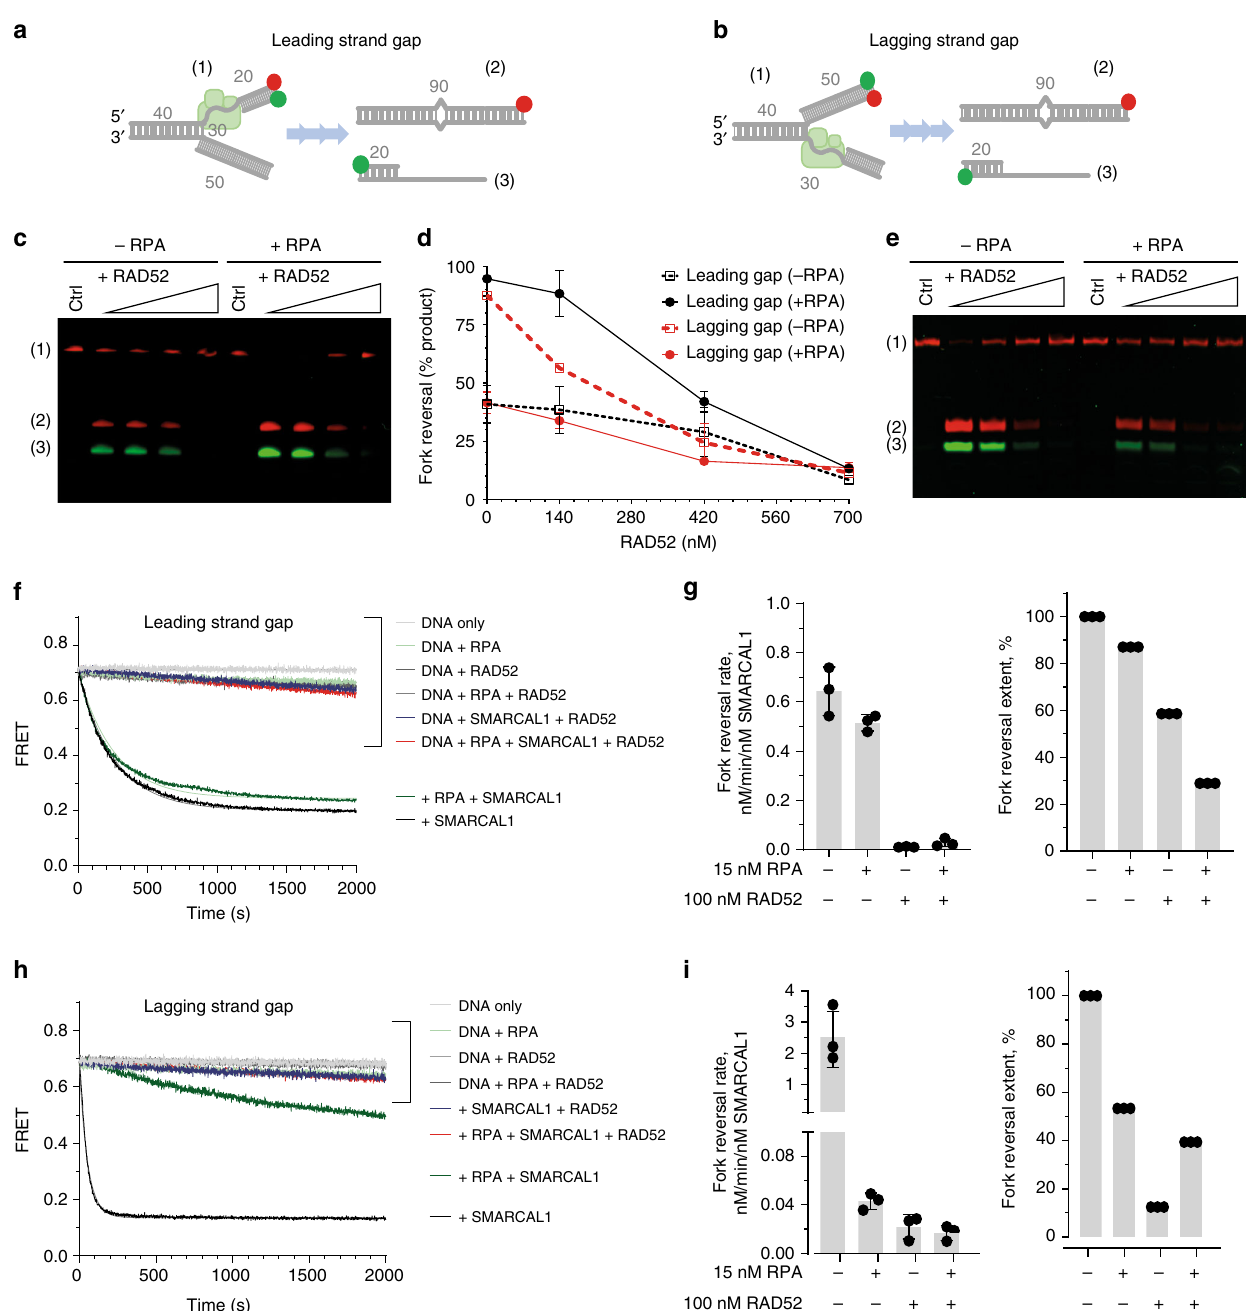
Fig. 5 RAD52 prevents fork reversal by SMARCAL1. a , b Cartoon depiction of the DNA substrates and the reversal reaction employing synthetic fork with a 30 nt gap on the leading ( a ) and lagging ( b ) strand, respectively. The lengths of the dsDNA and ssDNA features are marked in grey. Green circles depict Cy3 dyes, red circles depict Cy5 dyes. The substrate and the products of the fork reversal reactions are separated on the agarose gels after deproteinization. All reactions were carried out in the presence of 3 nM of forked DNA. c – e Representative gels and quanti fi cation of the fork reversal reactions by 20 nM SMARCAL1 in the presence of increasing concentrations of RAD52. Reactions were initiated by addition of SMARCA1 and stopped at 15 min. Only Cy5 channel data were used for quanti fi cation. f Representative fork reversal time courses for the DNA substrate containing a leading strand gap. Solid faint lines behind the experimental data indicate fi ts to a single exponential. g The rates of the fork reversal reactions and their extents were calculated by fi tting the data to exponential decay functions as described in the Methods section. The resulting rates are shown for three independent experiments. h , i The same as f , g , but for the substrate with a lagging strand gap. Source data are provided as a Source Data fi suggesting that RAD52 interacts with the RPA-bound ssDNA dynamic behaviour with each fork transitioning between different within these two substrates. RAD52 addition to the RPA-bound FRET states, which were higher than those observed for the RPA- RF2 and RF3 resulted in a high FRET peak, suggesting that both bound fork, suggesting a more compact conformation. Notably, the leading strand arm and the parental duplex are brought close the RAD52 binding to the G1, FR1, RF2 and RF3 substrates did to the lagging strand arm. Individual trajectories showed a highly not completely displace the RPA bound to the ssDNA region.